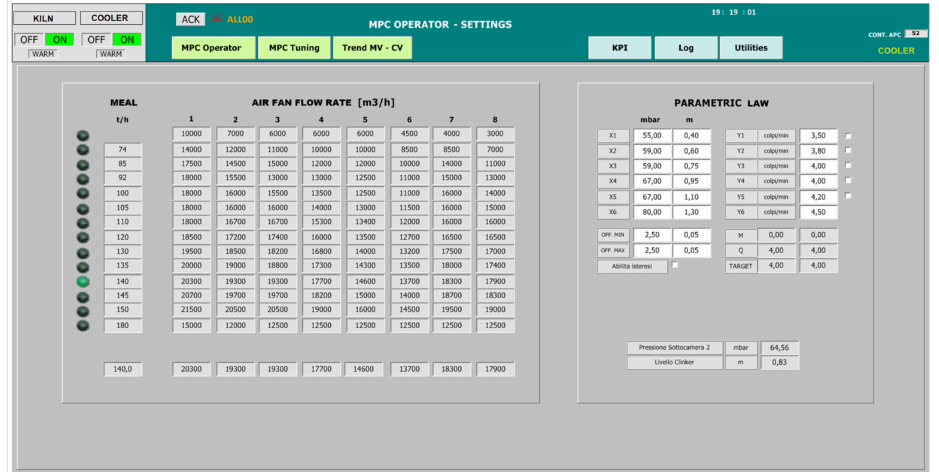
Figure 8. Grate cooler APC system: GUI synoptic for MVs nominal targets computation and para- metric law